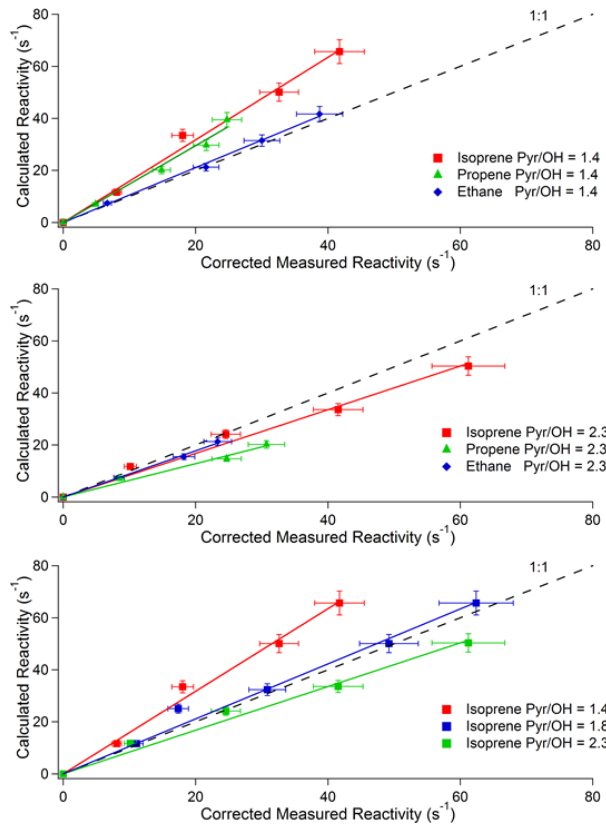
Figure 6. Experimental parameterization of the artifact caused by not operating the instrument under pseudo-first-order conditions. Comparison of OH reactivity values calculated from the addition of gas standards to measured values. Top panel: addition of three dif- ferent gas standards (isoprene: red squares; ethane: blue diamonds; and propene: green triangles) at a pyrrole-to-OH ratio of 1.4. Mid- dle panel: addition of the three gas standards at a pyrrole-to-OH ratio of 2.3. Bottom panel: addition of isoprene at three different pyrrole-to-OH ratios (1.4: red squares; 1.8: blue squares; and 2.3: green